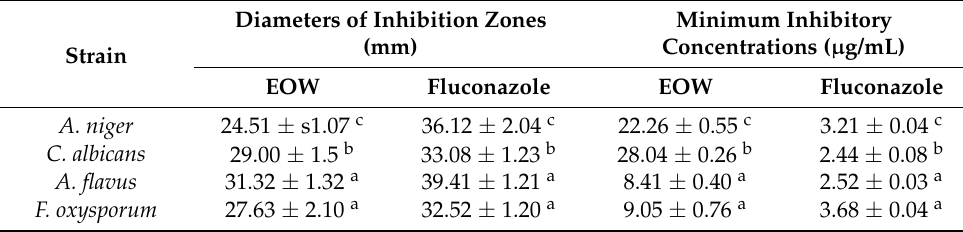
Table 3. Diameters of zones of inhibition and MICs for EOW against fungal